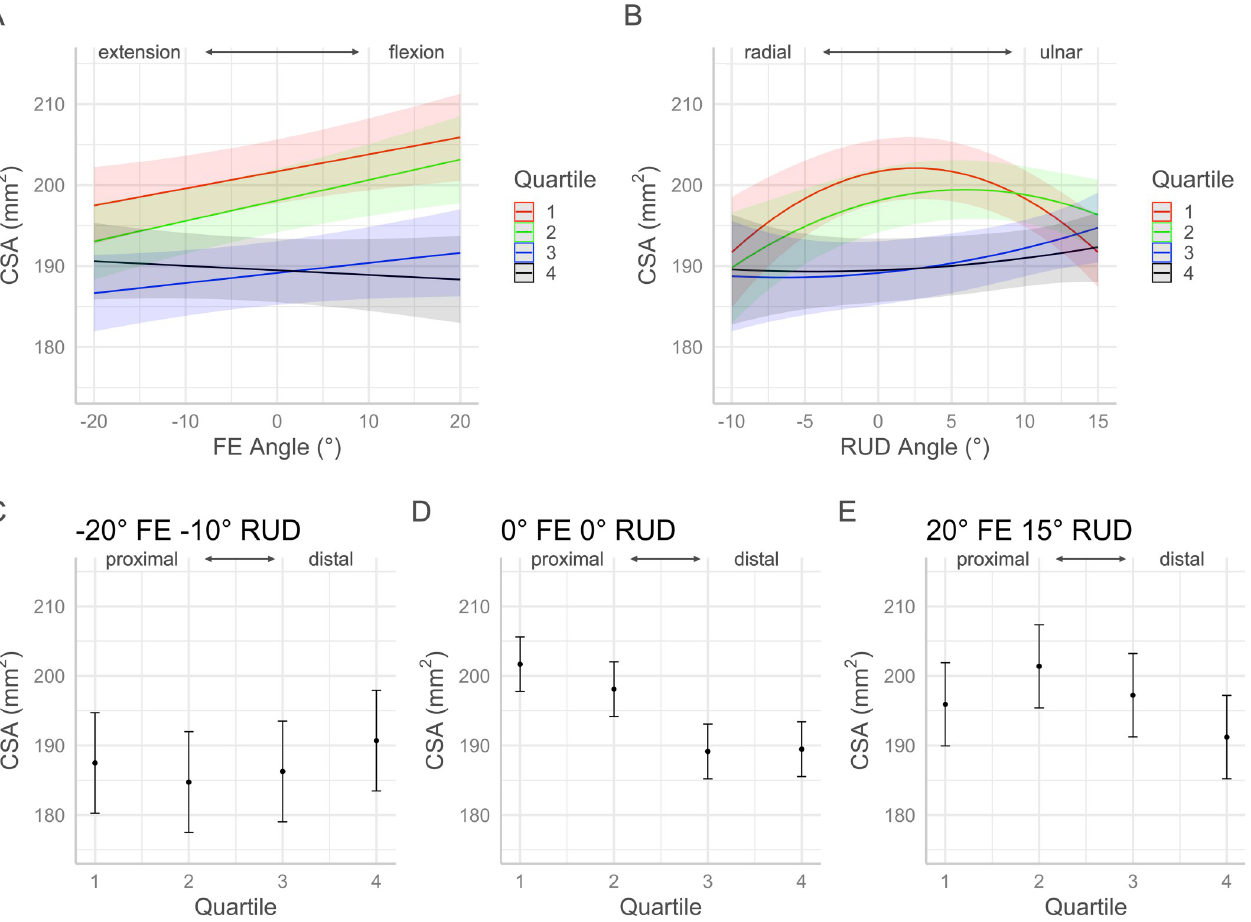
Fig 6. Effects of FE and RUD wrist postures on the mean cross-sectional area within each quartile. Panel A shows the effects of varying FE angle with 0˚ RUD. Panel B shows the effect of varying RUD angle with 0˚ FE. Panels C/D/E show the predicted values with 95% confidence intervals for each quartile for an extended radially deviated posture (panel C), a neutral posture (panel D), and a flexed and ulnarly deviated posture (panel E).